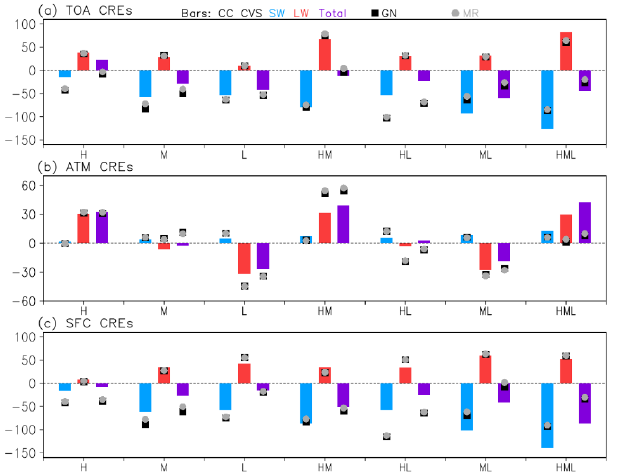
Figure 5. As Fig. 4, but for all-sky (RFO-weighted)